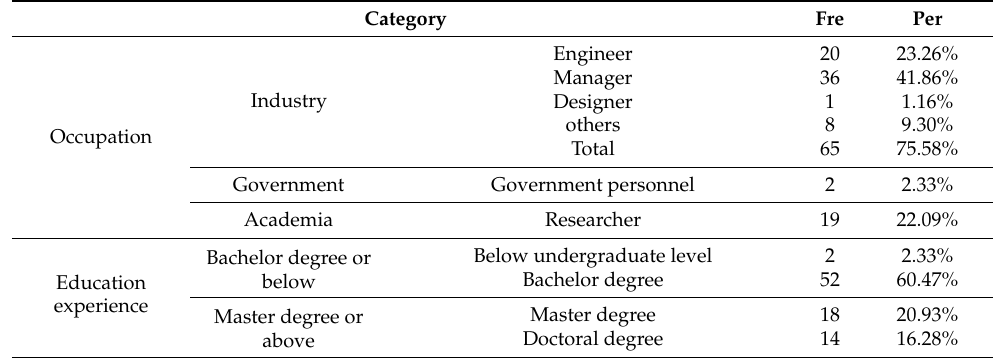
Table 4. Respondents’